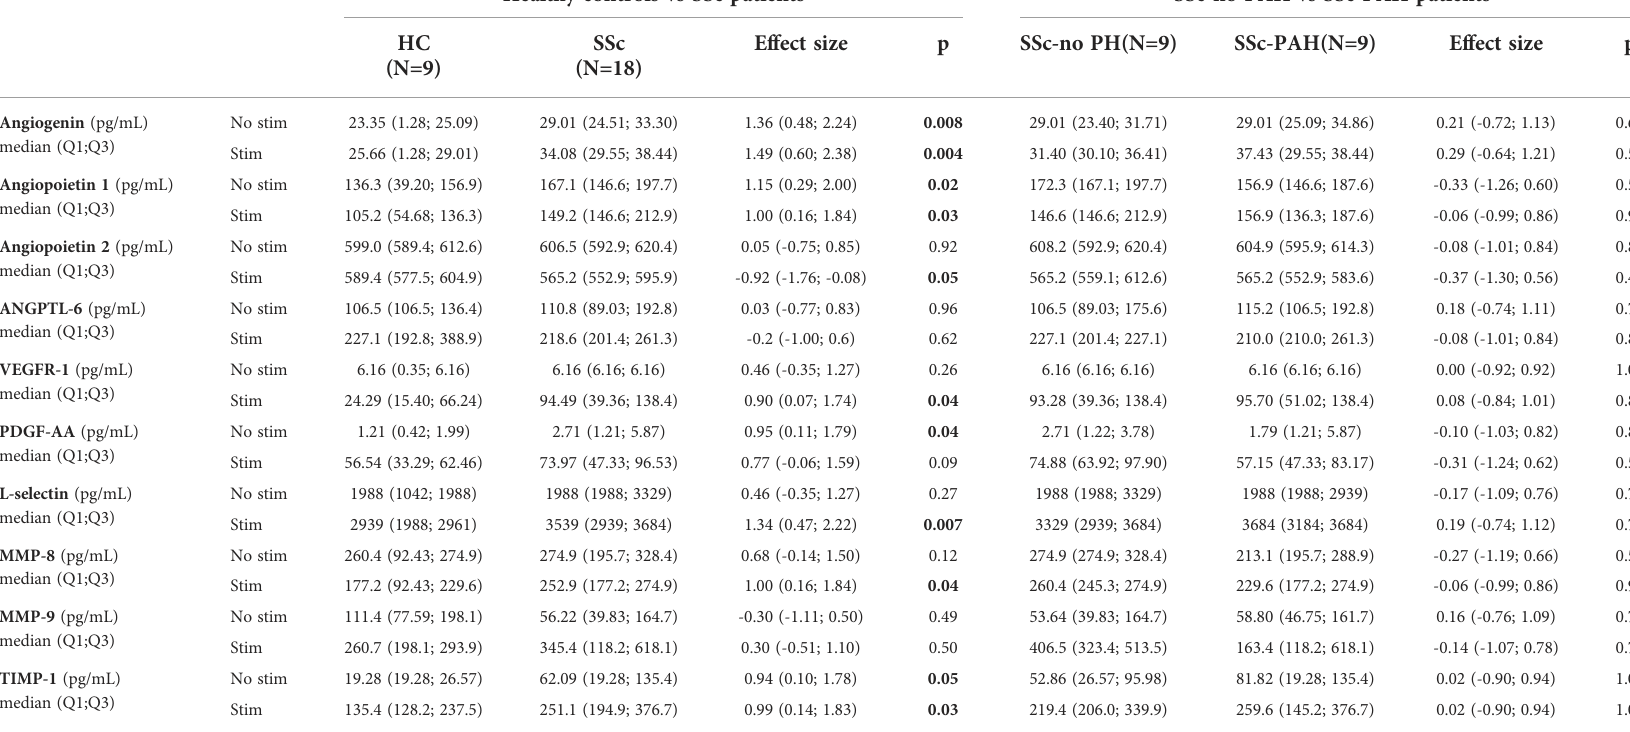
TABLE 7 Concentrations of angiogenic mediators in B cell culture supernatants from healthy controls, and SSc patients with and without PAH from the validation cohort. Healthy controls vs SSc patients